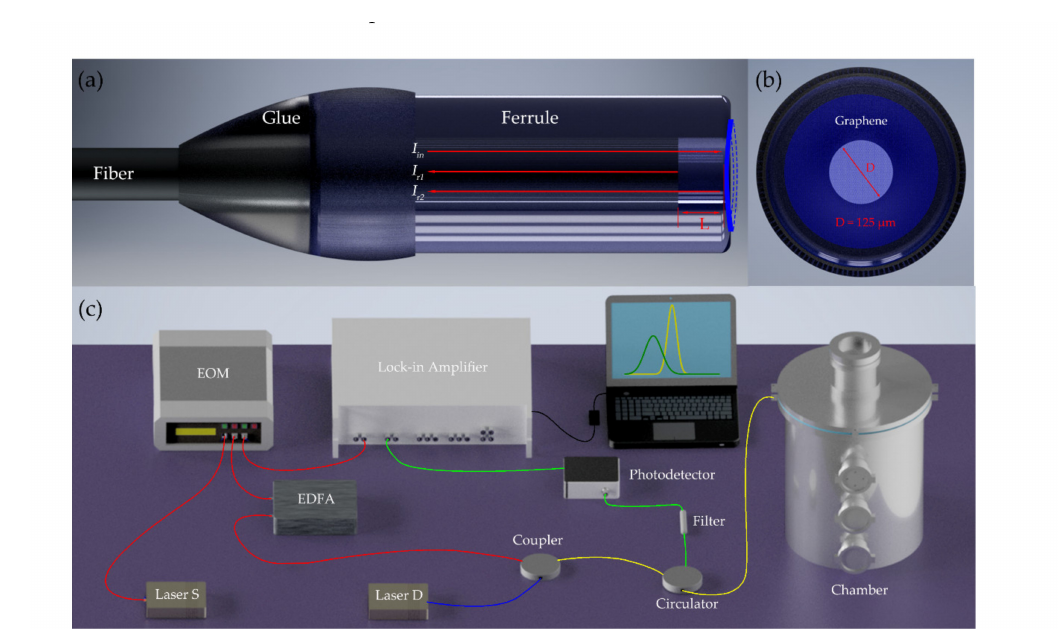
Figure 1. ( a ) Front view and ( b ) lateral view of the schematic diagram of the F-P resonant probe. ( c ) Scheme of the optical-thermal actuation setup for resonance